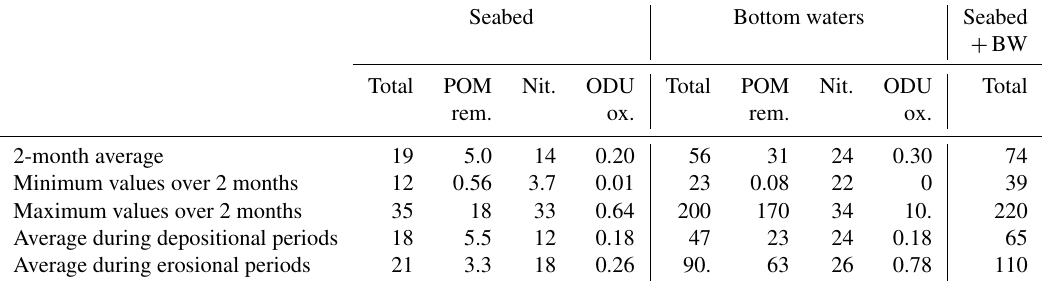
Table 6. O 2 Consumption (mmol O 2 m − 2 d − 1 ) in the seabed, bottom water, and combined seabed-bottom water due to various processes over the 2-month model run, and during periods of deposition and erosion. Abbreviations include: POM rem. (particulate organic matter remineralization); ODU ox. (oxidation of ODUs); Nit. (nitrification); and “Seabed + BW” (the combined seabed–bottom-water region). Seabed Bottom waters Seabed + BW Total POM Nit.